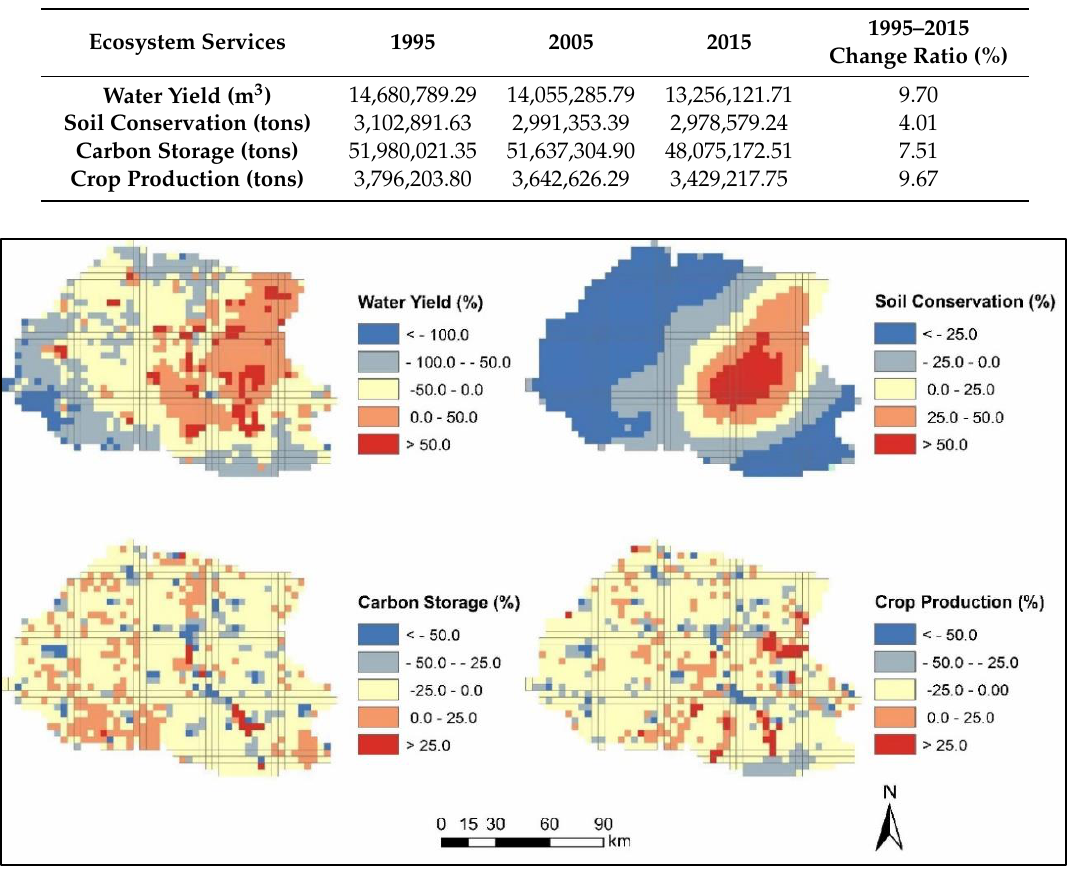
Figure 4. Spatial distributions of variations in ecosystem services between 1995 and 2005.